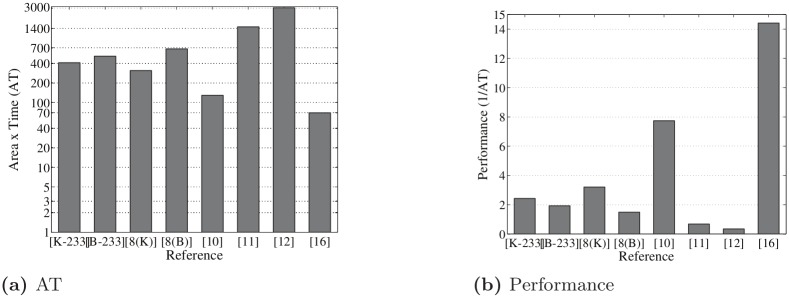
Comparison ((a) AT and (b) performance) of point multiplication over GF(2233).